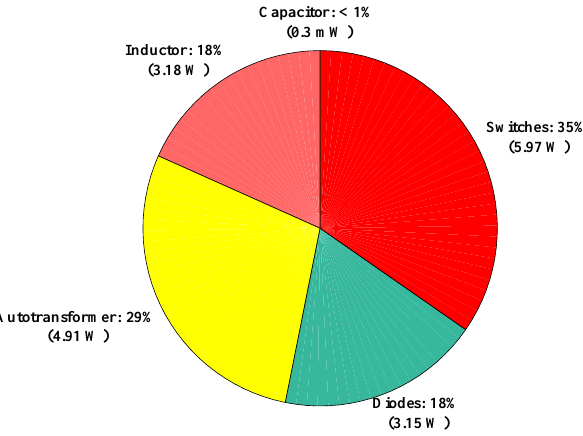
Figure 13. Theoretical distribution of power losses.